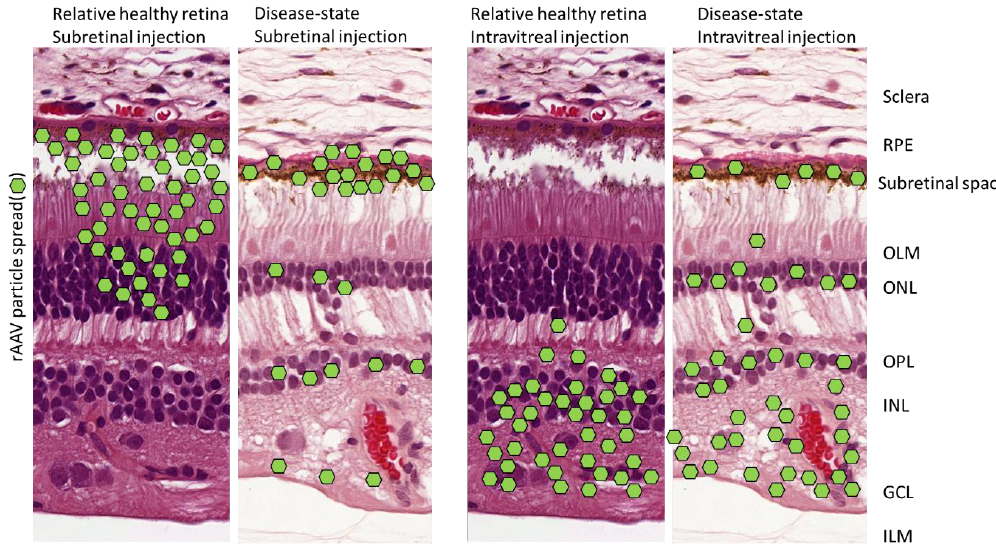
Figure 5. A hypothetical model of the spread of rAAV capsids (serotypes 1, 2, 5 8, and 9) after intravitreal or subretinal injection in disease or non-disease mouse retinas in vivo based on the studies [99,294,304,306,308,309]. RPE, retinal pigment epithelium; OLM, outer limiting membrane, ONL, outer nuclear layer; OPL, outer plexiform layer; INL, inner nuclear layer; GCL, ganglion cell layer; ILM, Inner Limiting Membrane.